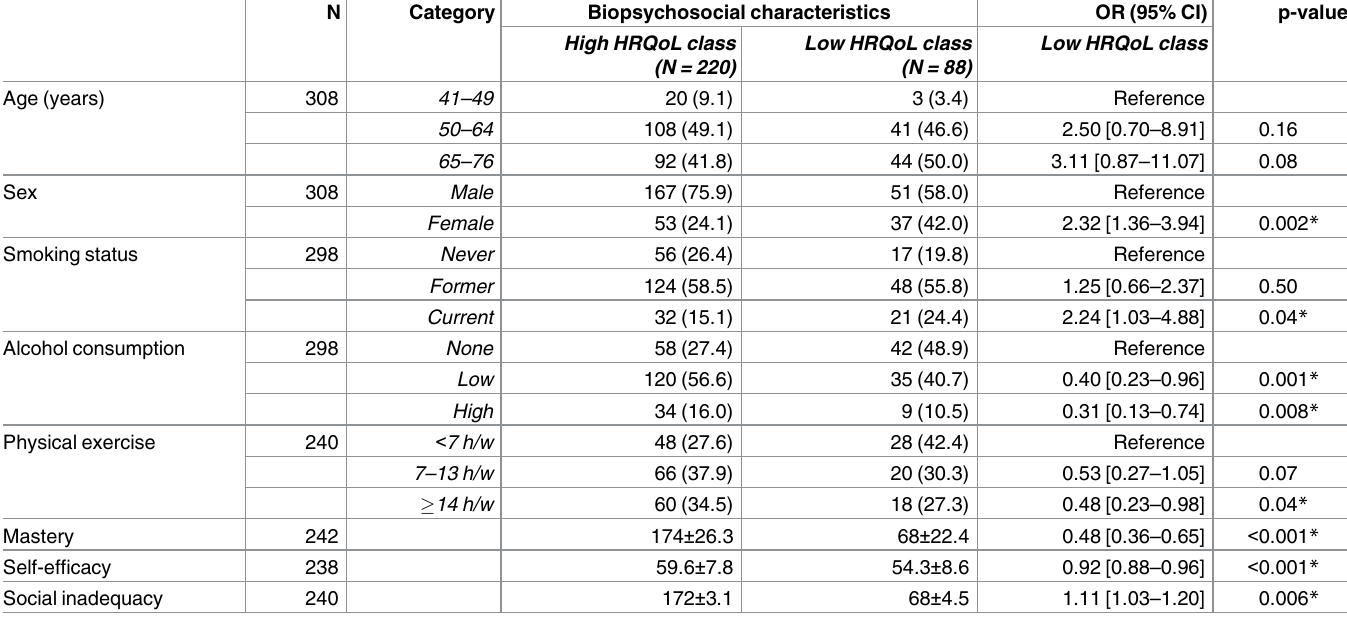
Table 6. Person-related characteristics of T2DM patient across different classesof HRQoL.